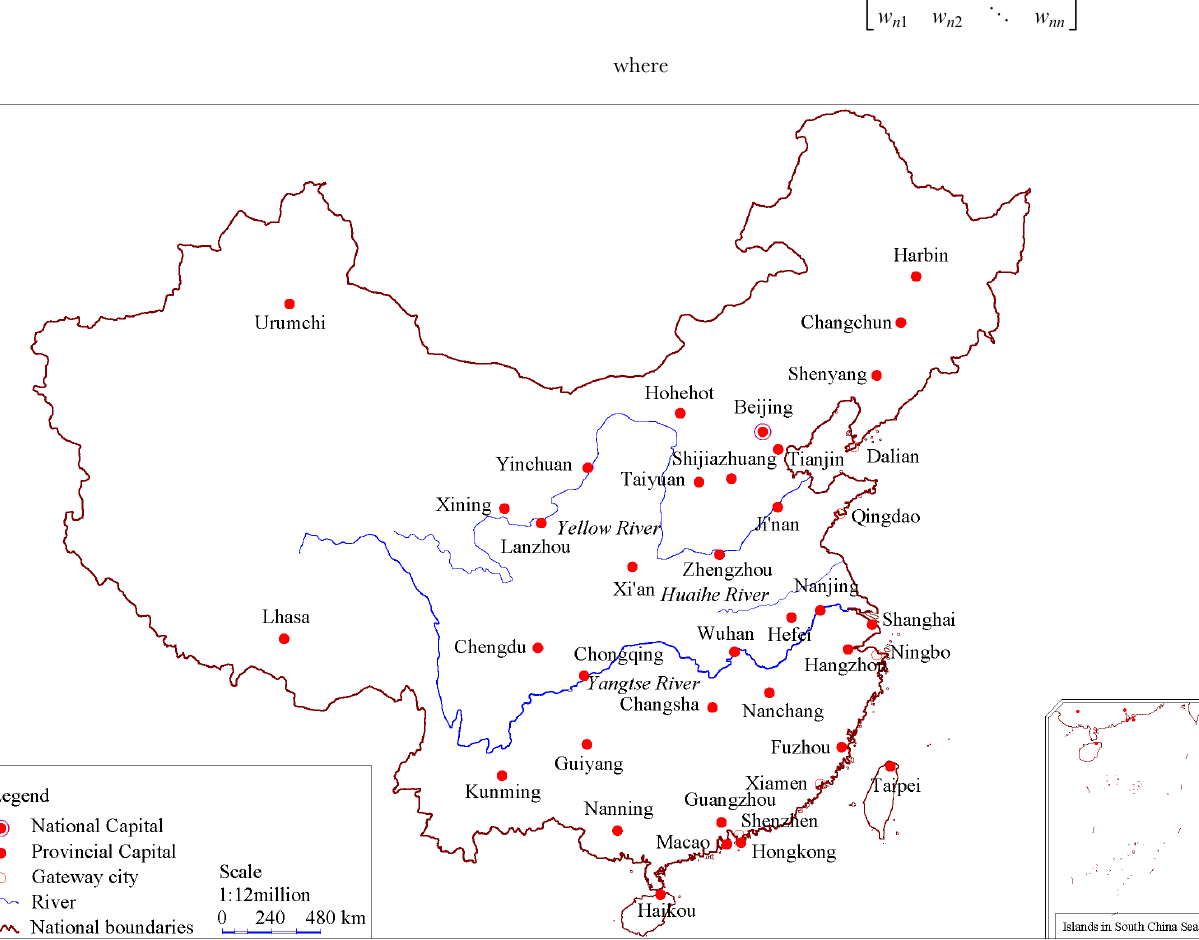
Figure 2. A sketch map of the geographic relationship of the principal cities of China.